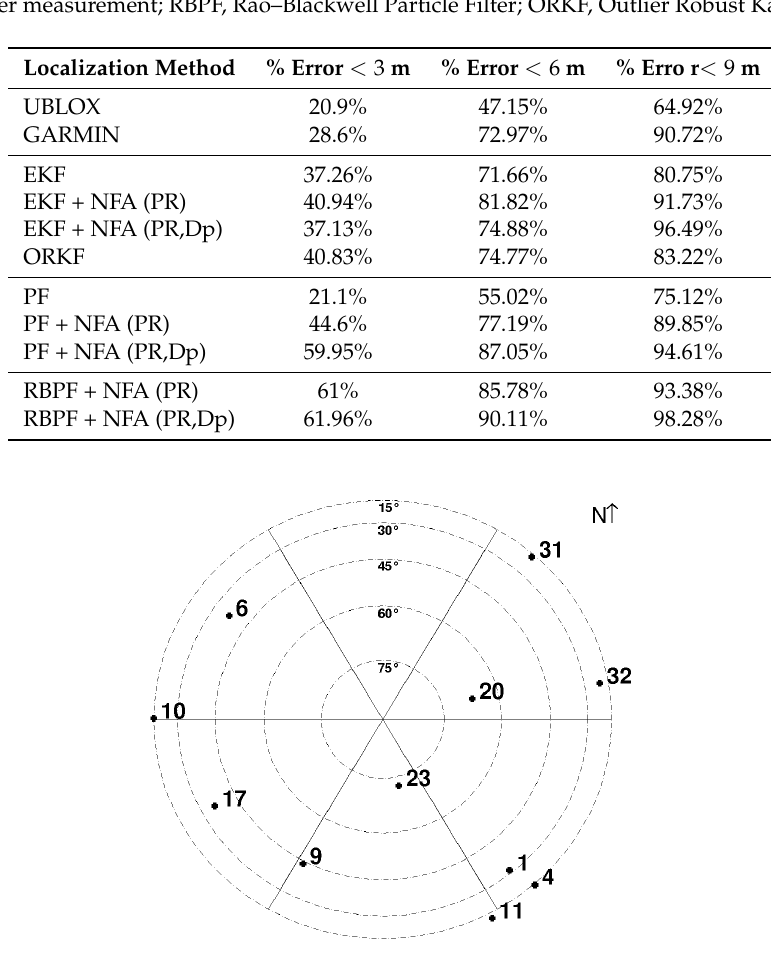
Figure 2. Skyplot configuration during the experimental data acquisition in the urban